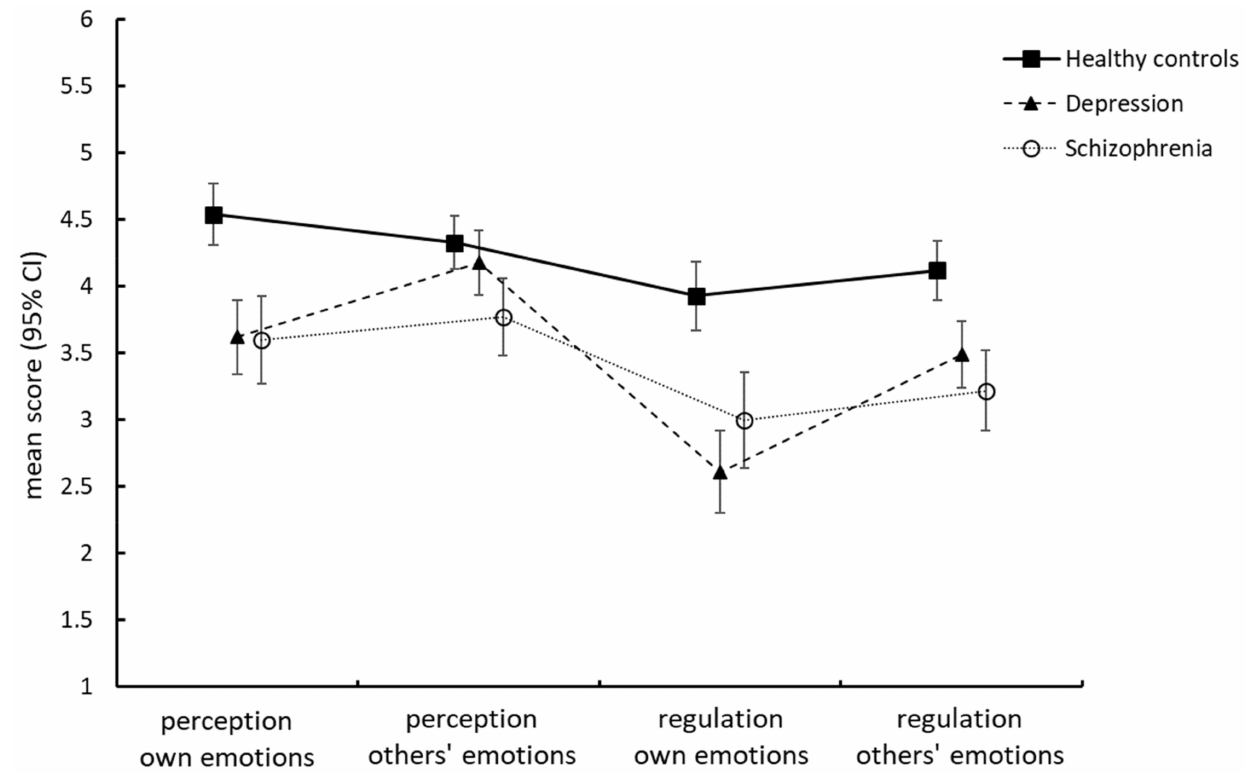
Figure 1. Profiles of self-perceived abilities in four core domains of emotional